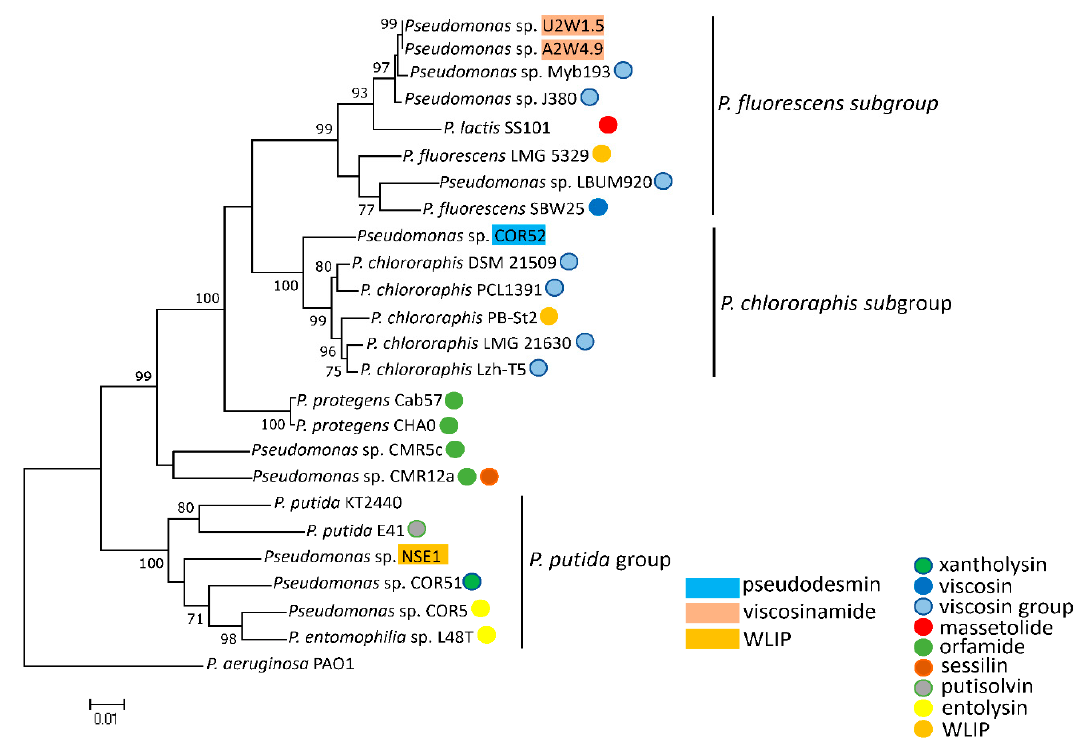
Figure 5. MLSA-derived phylogenetic analyses of Pseudomonas isolates carrying Viscosin-group BGCs. Partial sequences of 16S rRNA, gyrB , rpoB and rpoD genes were used to make separate trees and concatenated afterwards, to generate a consensus tree. Other biocontrol CLP-producing isolates and type strains were included in this analysis. P. aeruginosa was used as an outgroup. A maximum likelihood tree was made and bootstraps are only indicated for branches with bootstrap support of higher than 70%. CLPs from strains denoted in rectangular, colored boxes were described in this study, while those marked with color-filled dots were characterized in previous studies, except for light blue dots representing putative Viscosin group producers for which the CLP has not been characterized.